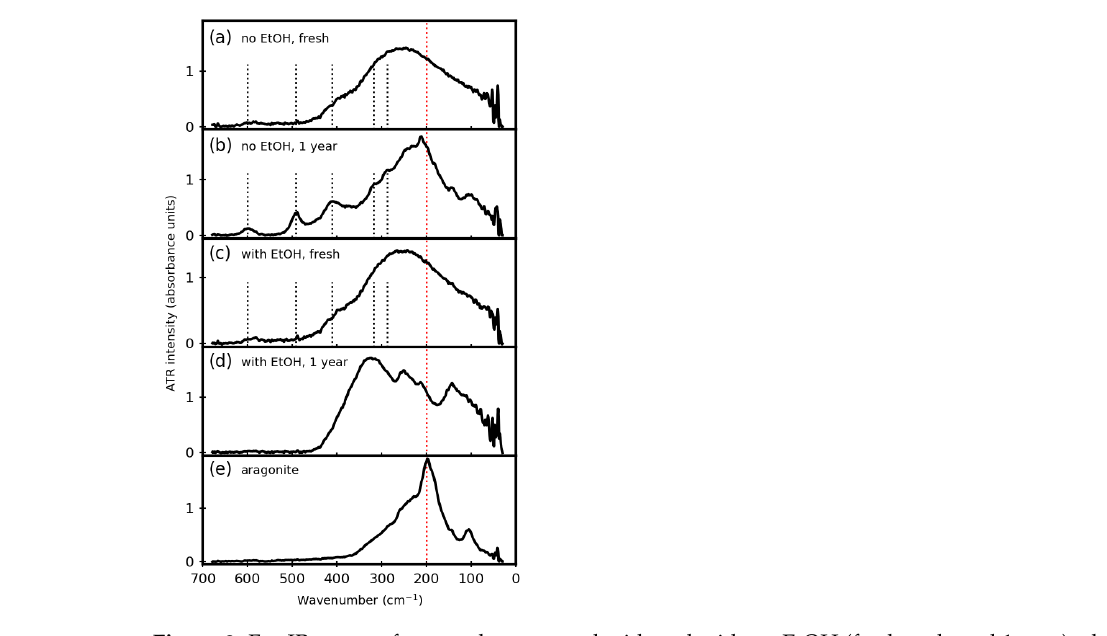
Figure 3. Far-IR spectra for samples prepared with and without EtOH (fresh and aged 1 year), along with an aragonite standard. The red dotted vertical line indicates the main aragonite peak. The five black dotted vertical lines indicate peaks that appear only in the no-EtOH sample after